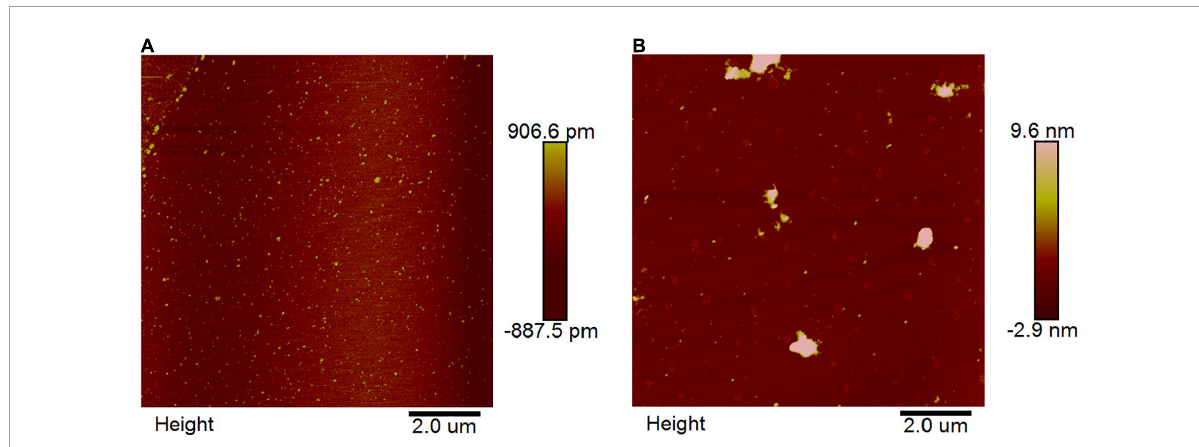
FIGURE5 AFM images of free α -glucosidase (A) and the interaction between EA and α -glucosidase (B) . The concentrations of α -glucosidase and EA were 2.0 U/mL and 40 µ g/mL, respectively. EA and α -glucosidase were co-incubated for 30 min at 37 ◦ C before preparing on the mica plate for